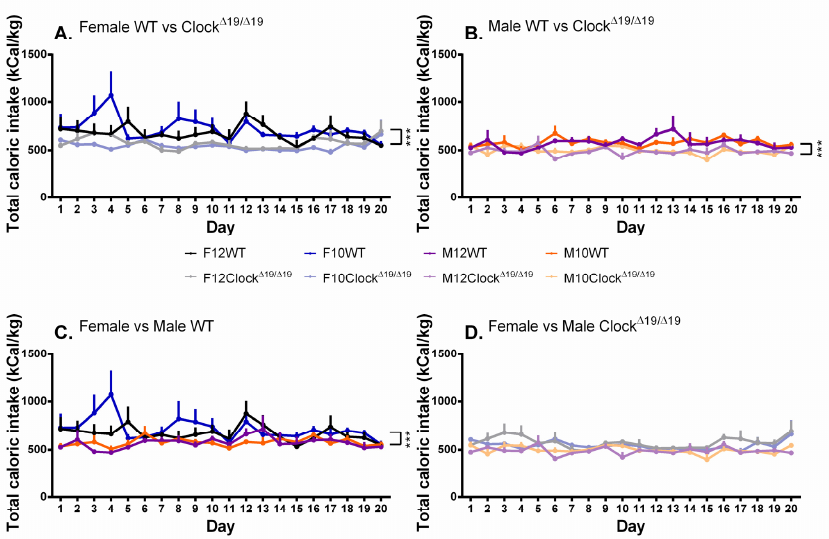
Figure 7. The total caloric intake by mice is influenced by sex and genotype but not L:D cycle. ( A ). Female WT mice consumed fewer calories than female Clock Δ 19/ Δ 19 across the 20-day testing period. ( B ). Male WT mice consumed fewer calories than male Clock Δ 19/ Δ 19 mice across the 20-day testing period. ( C ). Female WT mice consumed more calories than male WT mice across the 20-day testing period. ( D ). Female and male Clock Δ 19/ Δ 19 mice demonstrated similar amounts of calories consumed. F = females, M = males; 12 = 12:12 L:D cycle, 10 = 10:10 L:D cycle; WT = wild-type. Darker tones are WT mice and lighter tones are Clock Δ 19/ Δ 19 mice. Black = female 12:12 L:D group, blue = female 10:10 L:D group, purple = male 12:12 L:D group, orange = male 10:10 L:D group. *** = p < 0.001.